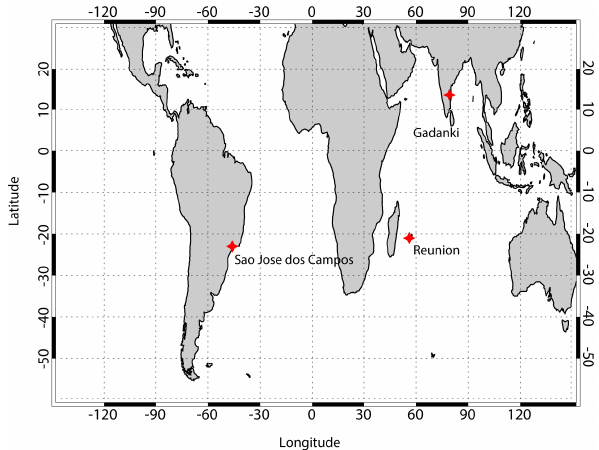
Fig. 1. Map showing the locations of the three stations (São José dos Campos, Reunion, and Gadanki) where long-term Lidar data observations were made